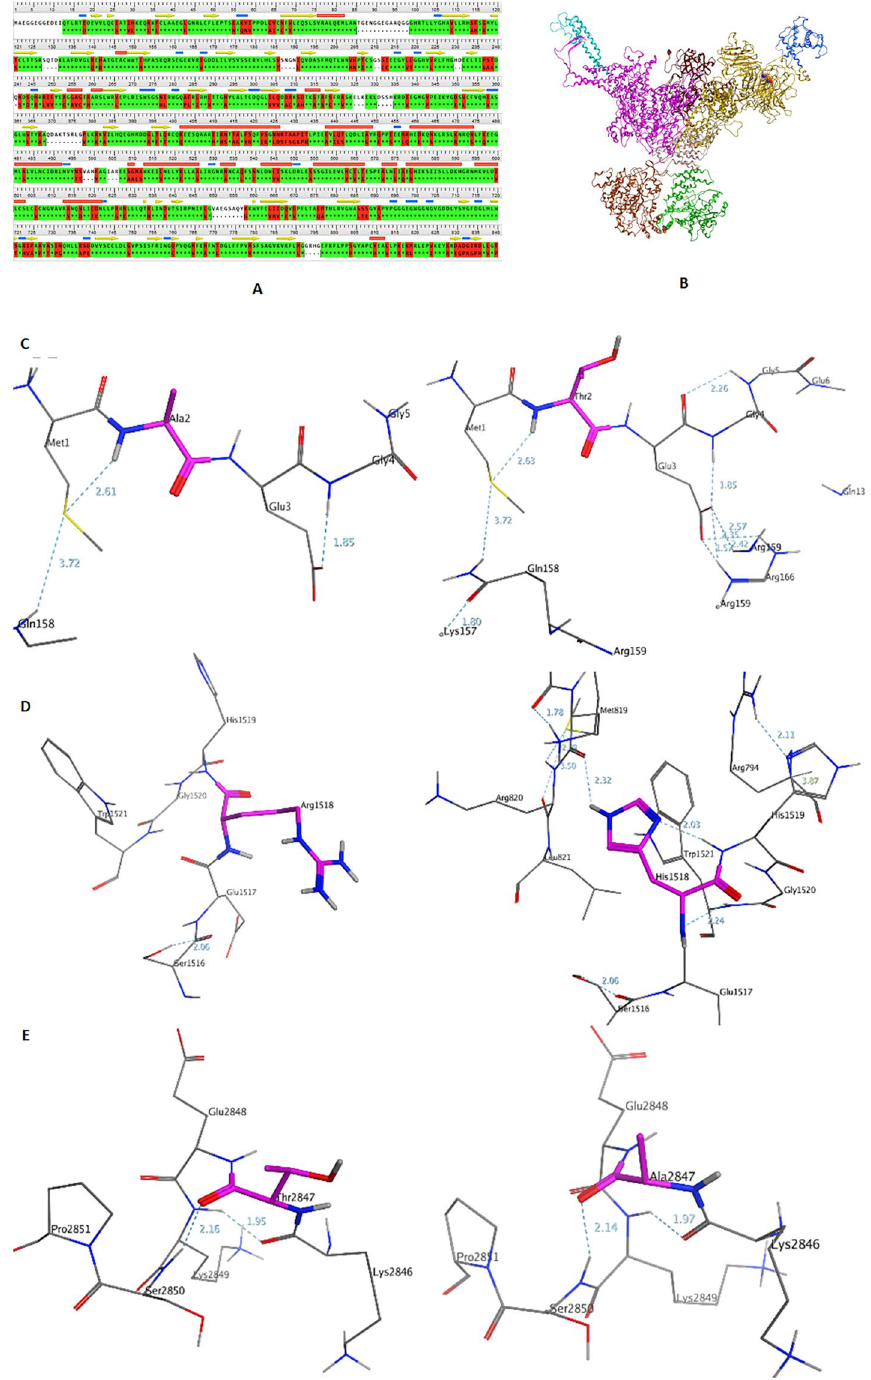
Figure 5. Analysis of conformational changes in mutant proteins. ( A ) The sequence alignment (part of the whole sequence) between Homo sapiens RYR3 (up) and Oryctolagus cuniculus RYR1 (down). The sequence identity is approximately 64.6%. ( B ) The homology model of the RYR3 receptor obtained by using MOE. The three mutation sites: A2, R1518 and T2847 are highlighted in the ball mode. Localized interactions at the three mutation sites: A2, R1518 and T2847. (left: C,D , and E ) shows the original structures, T2, H1518 and A2847. (right: C,D , and E ) shows the mutated structures. The three core residues are highlighted in purple and the hydrogen bonds formed around them are